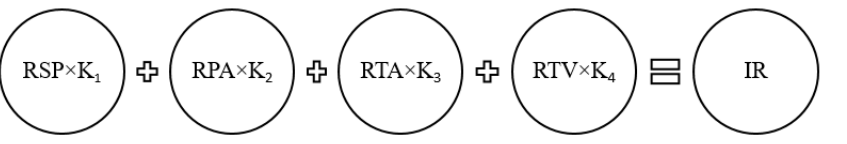
Table 3. Assessment of risk factors influence on achieving the goals for MSW sorting in selected regions of the Russian Federation (Part II).